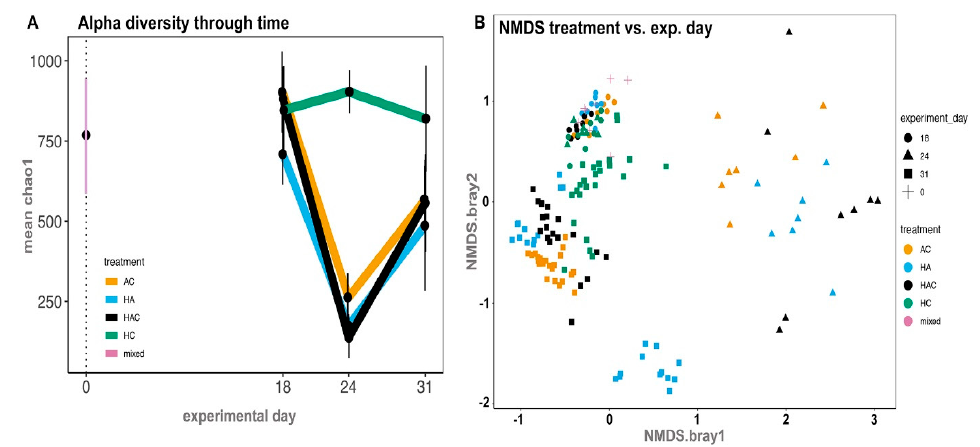
Figure 4. Microbial analyses throughout the experiment in rat fecal samples—after colonization (Day 18), after antibiotic treatment (Day 24) and after colitis treatment (Day 31). ( A ) Changes in the alpha diversity in the groups throughout the experiment; ( B ) NMDS analyses of the compositional changes in gut microbiota throughout the experiment, comparing treatment (in color) versus experimental day (in shape). For more details about the experimental groups and treatments, see Figure 1 or Supplementary Data S1